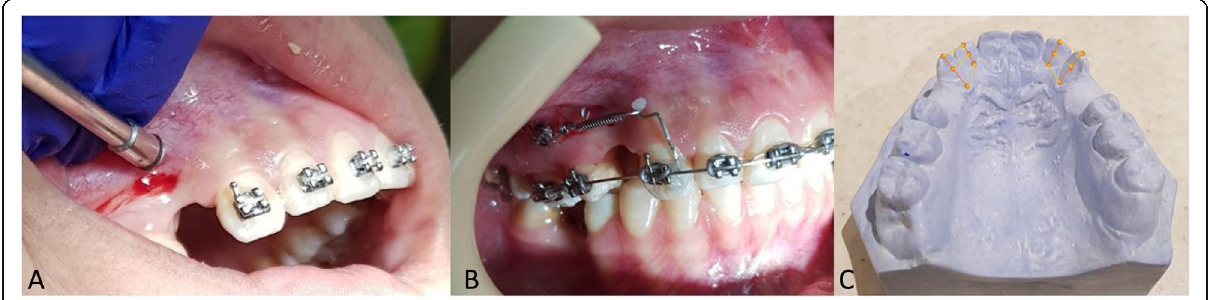
Fig. 1 MOP procedure ( a ), closed-coil nickel-titanium spring stretched between the power arm and the mini-screw ( b ), canine retraction was calculated on the casts by measuring the distance between the 2 lines drawing on the midline of canine and lateral incisor, at 3 points: incisal, middle, and cervical thirds of the crowns ( c